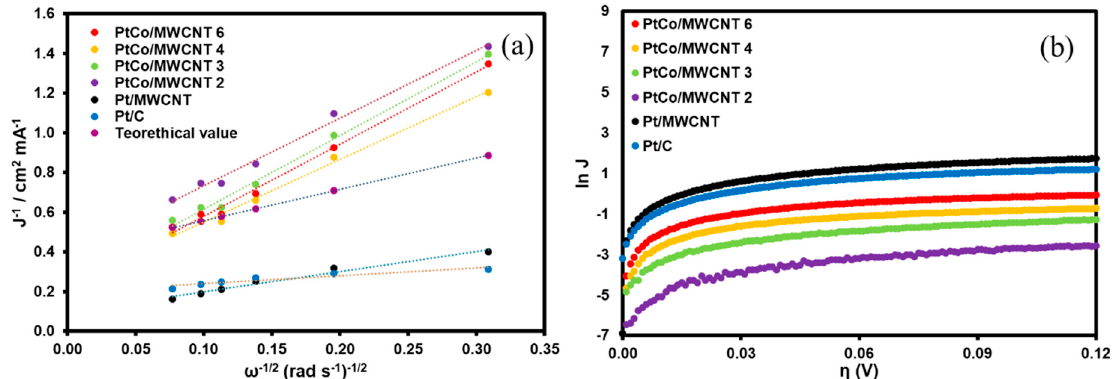
Figure 5. ( a ) Koutecky–Levich and ( b ) Tafel plots for PtCo/MWCNT; for comparison purpose, Pt/C and Pt/MWCNT are included in both analyses.